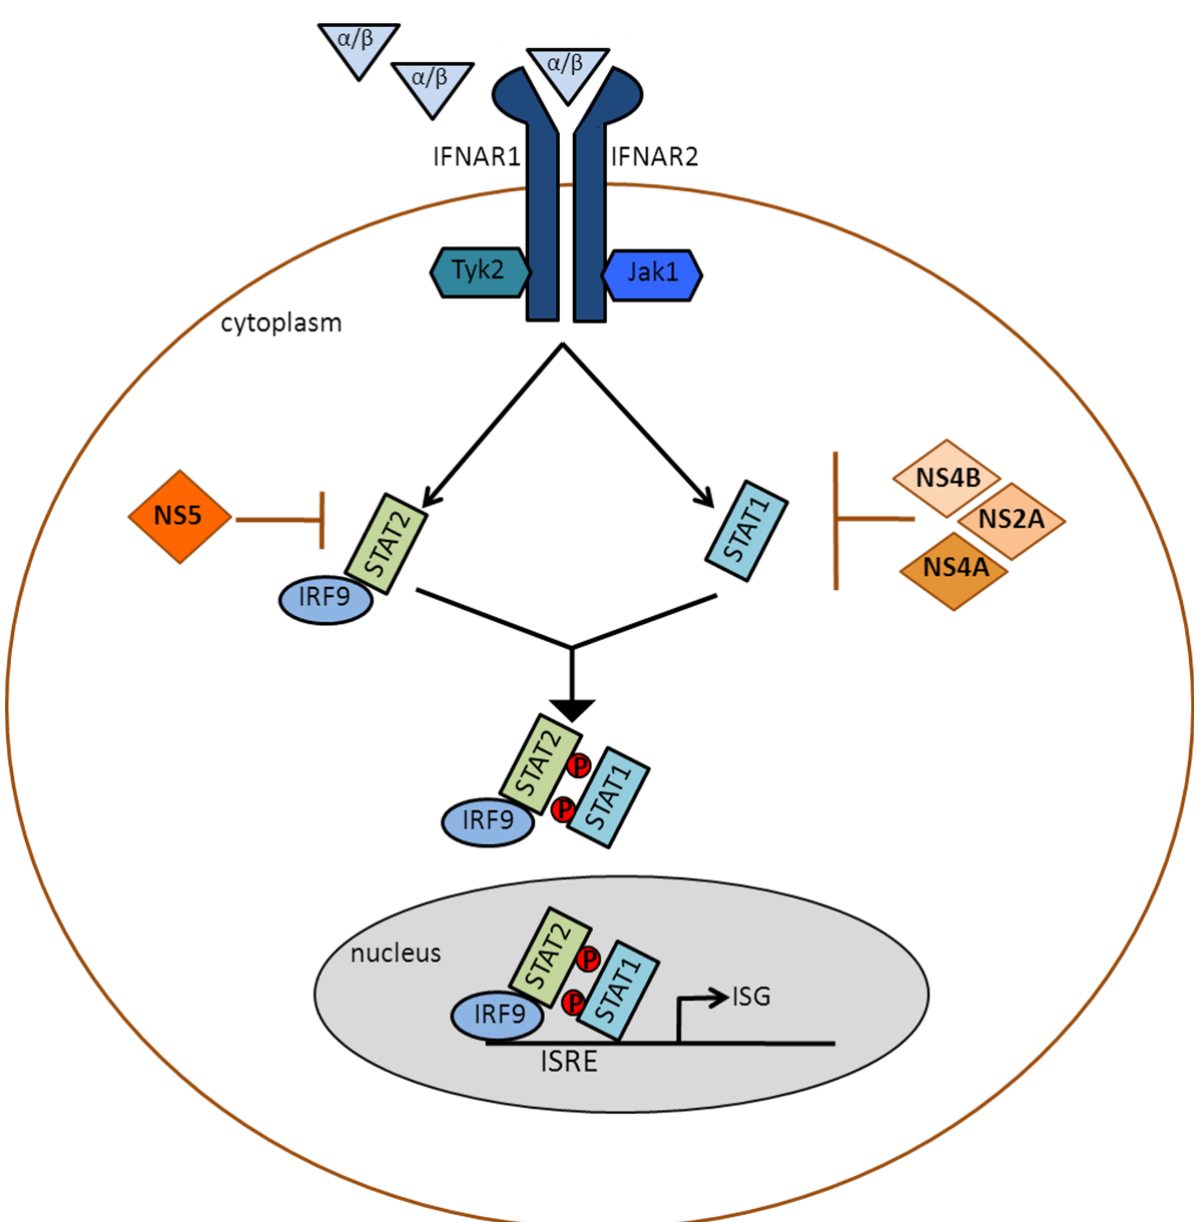
Figure 3. Inhibition of type I IFN signaling by DENV: IFN α / β binds the type I IFN receptor (IFNAR), which is composed of IFNAR1 and IFNAR2 and is found on the surface of nucleated cells. Receptor binding triggers tyrosine autophosphorylation of the Janus kinases, Jak1 and Tyk2. The activated kinases then phosphorylate STAT1 and STAT2. Activated STAT2, which is normally associated with IFN regulatory factor 9 (IRF9), associates with activated STAT1 to form the trimeric IFN-stimulated gene factor 3 (ISGF3) complex, which translocates to the nucleus and binds to the IFN-stimulated response element (ISRE) of IFN-stimulated genes (ISGs). Hundreds of ISGs are transcribed, and their products set up an antiviral state in the IFN-treated cell. DENV antagonizes this signaling pathway by utilizing NS5 to degrade STAT2, and by using NS2A, NS4A and NS4B to inhibit steps upstream of STAT1